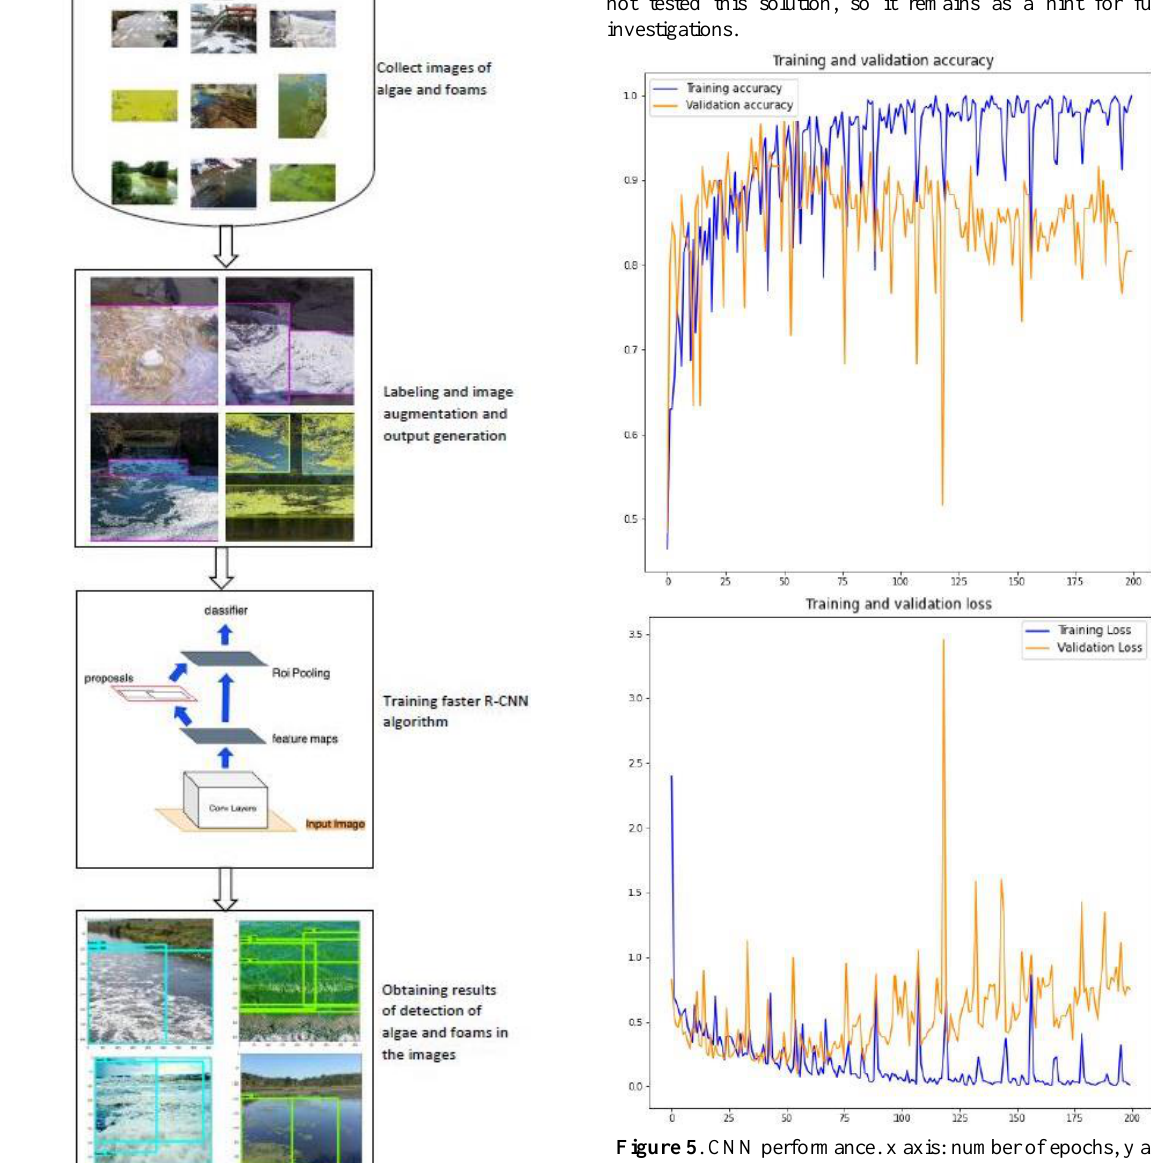
Figure 5 . CNN performance. x axis: number of epochs, y axis Top: Accuracy; Bottom: